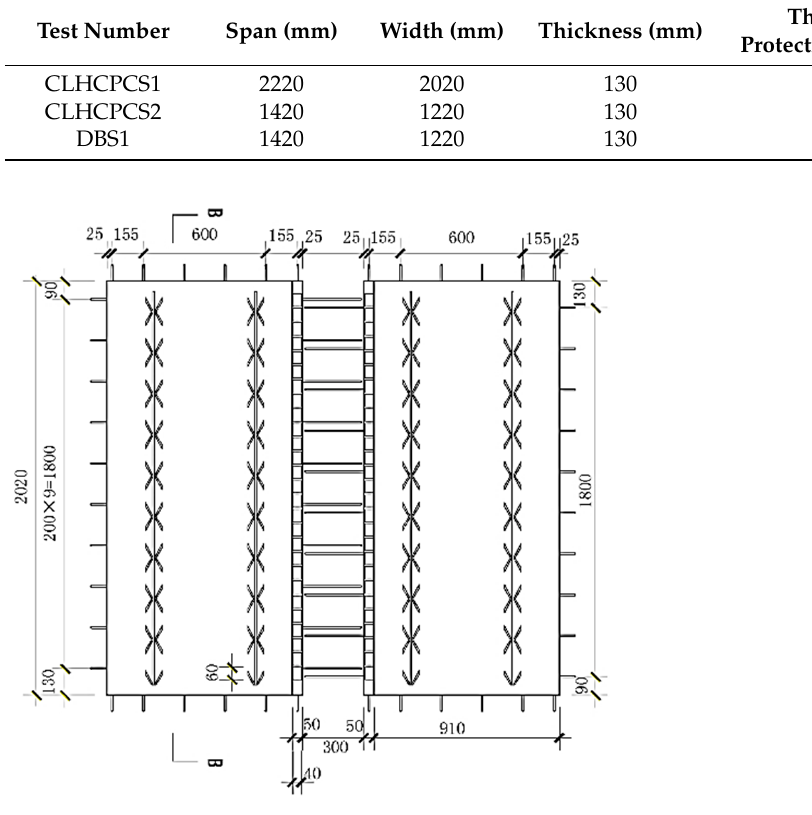
Figure 2. The reinforcement diagram of the precast layer of the specimen.